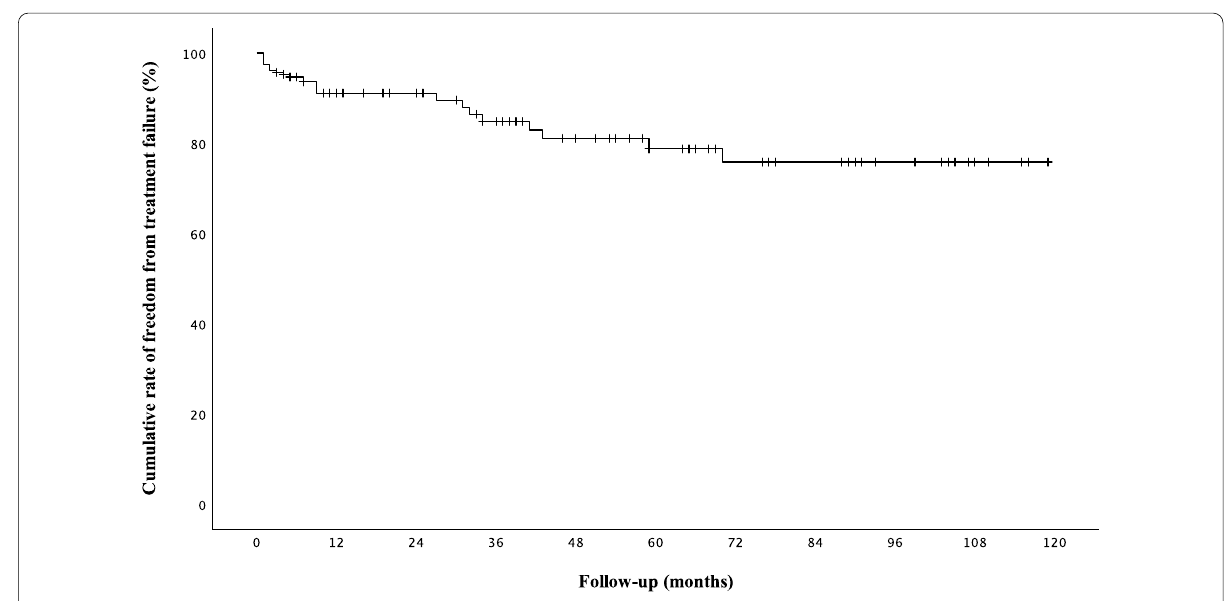
Fig. 2 Cumulative rate of freedom from treatment failure according to Kaplan–Meier